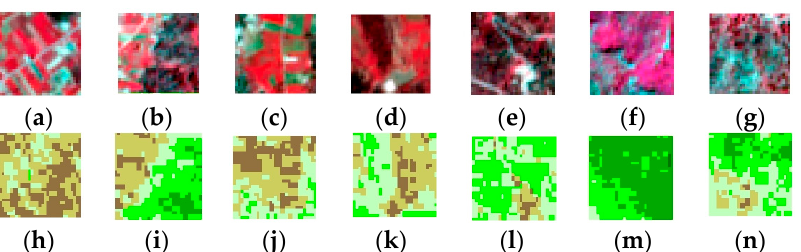
Figure 9. Different sub-images showing ( a – g ) the original Sentinel-2 images and ( h – n ) canopy density (very low, low, medium, high, and very high).